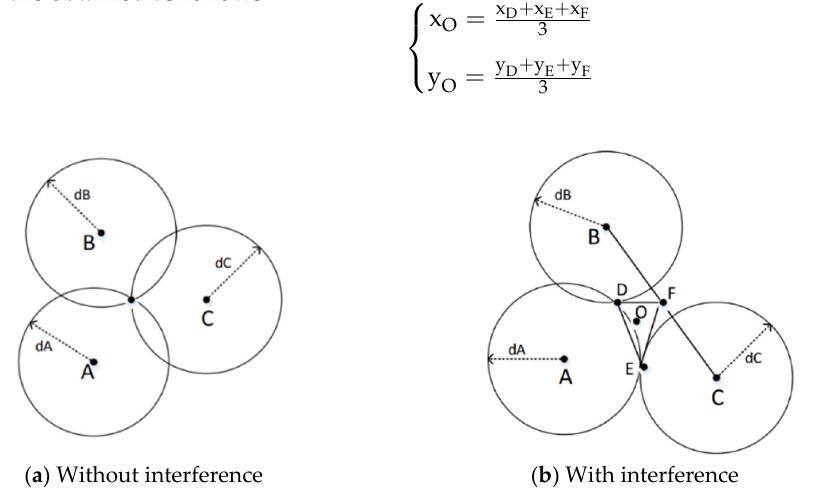
Figure 4. Triangulation and centroid positioning (( a )without interference, ( b )with interference).